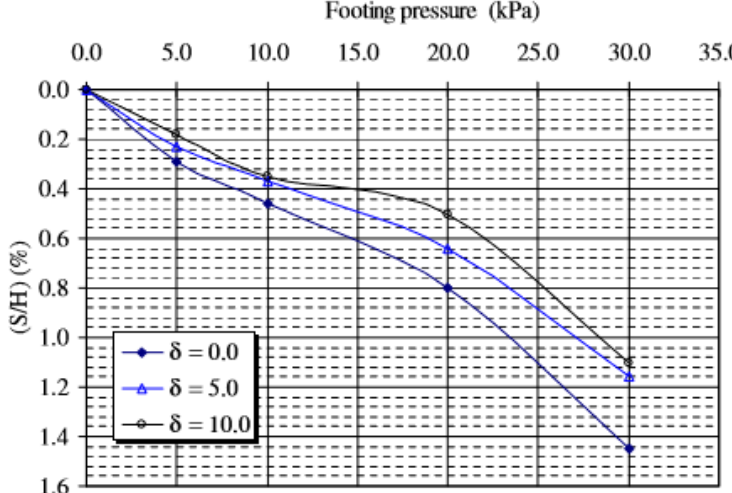
Figure 16. Influence of nail inclination on the settlement of the footing.